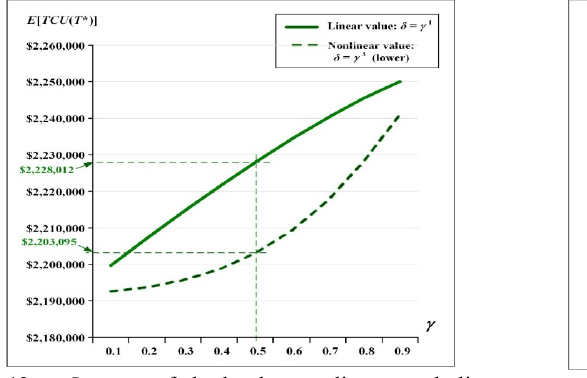
Fig. 13. Behavior of E [ TCU ( T *)] concerning the collective influence from x and γ